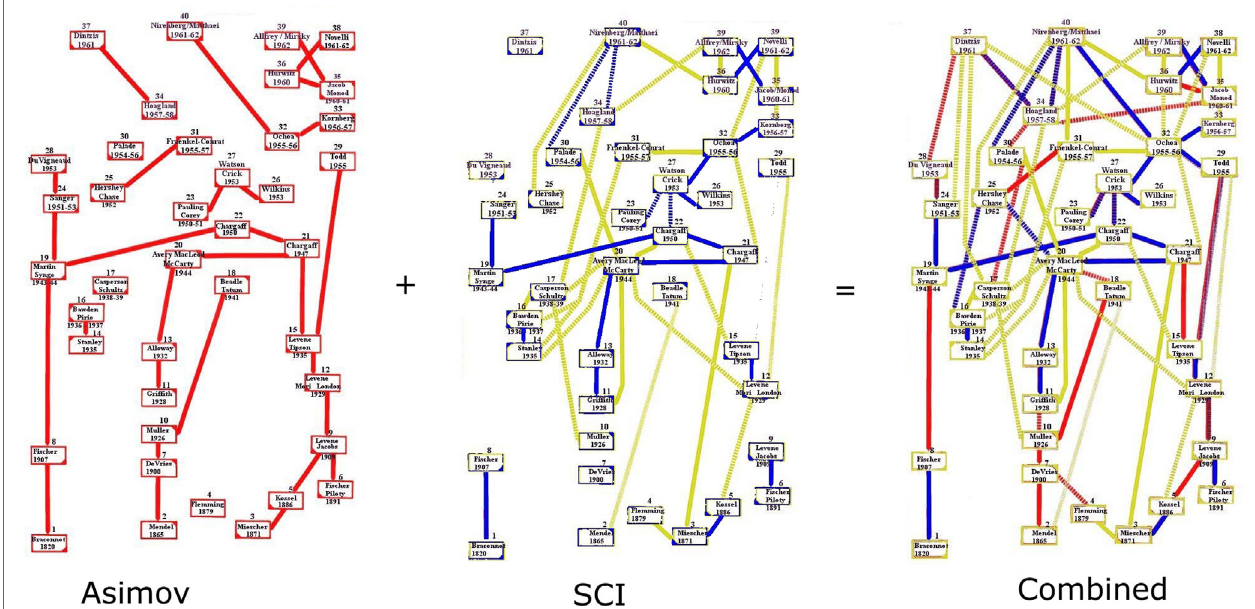
FiGURE 3 | Comparison of citation linkages in described in Isaac Asimov’s The Genetic Code and from the Science Citation Index . Reproduced by permission of the executor of the estate of Dr. Eugene